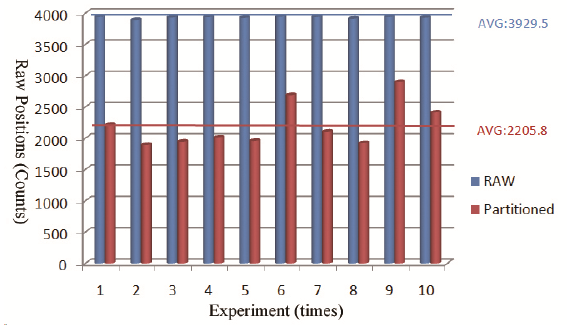
Fig. 6. Comparison of storage usage between raw